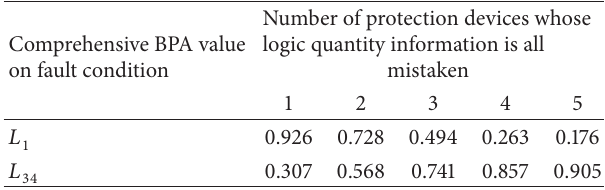
Table 5: WABP performance under mistaken condition B when a fault occurs on 𝐿 1